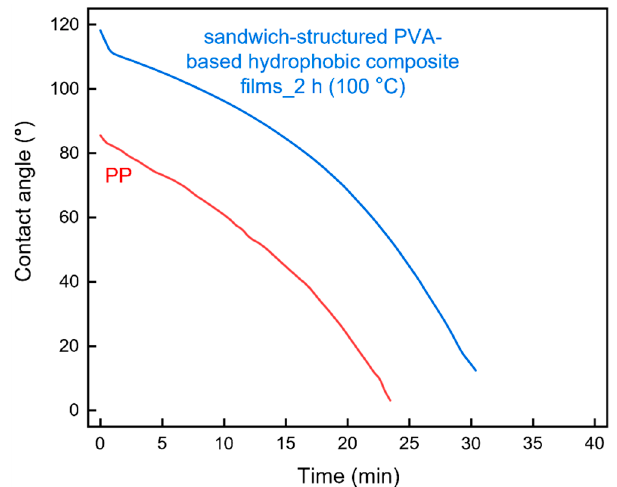
Figure 16. Contact angles of the sandwich-structured PVA-based hydrophobic composite film and commercially available PP.